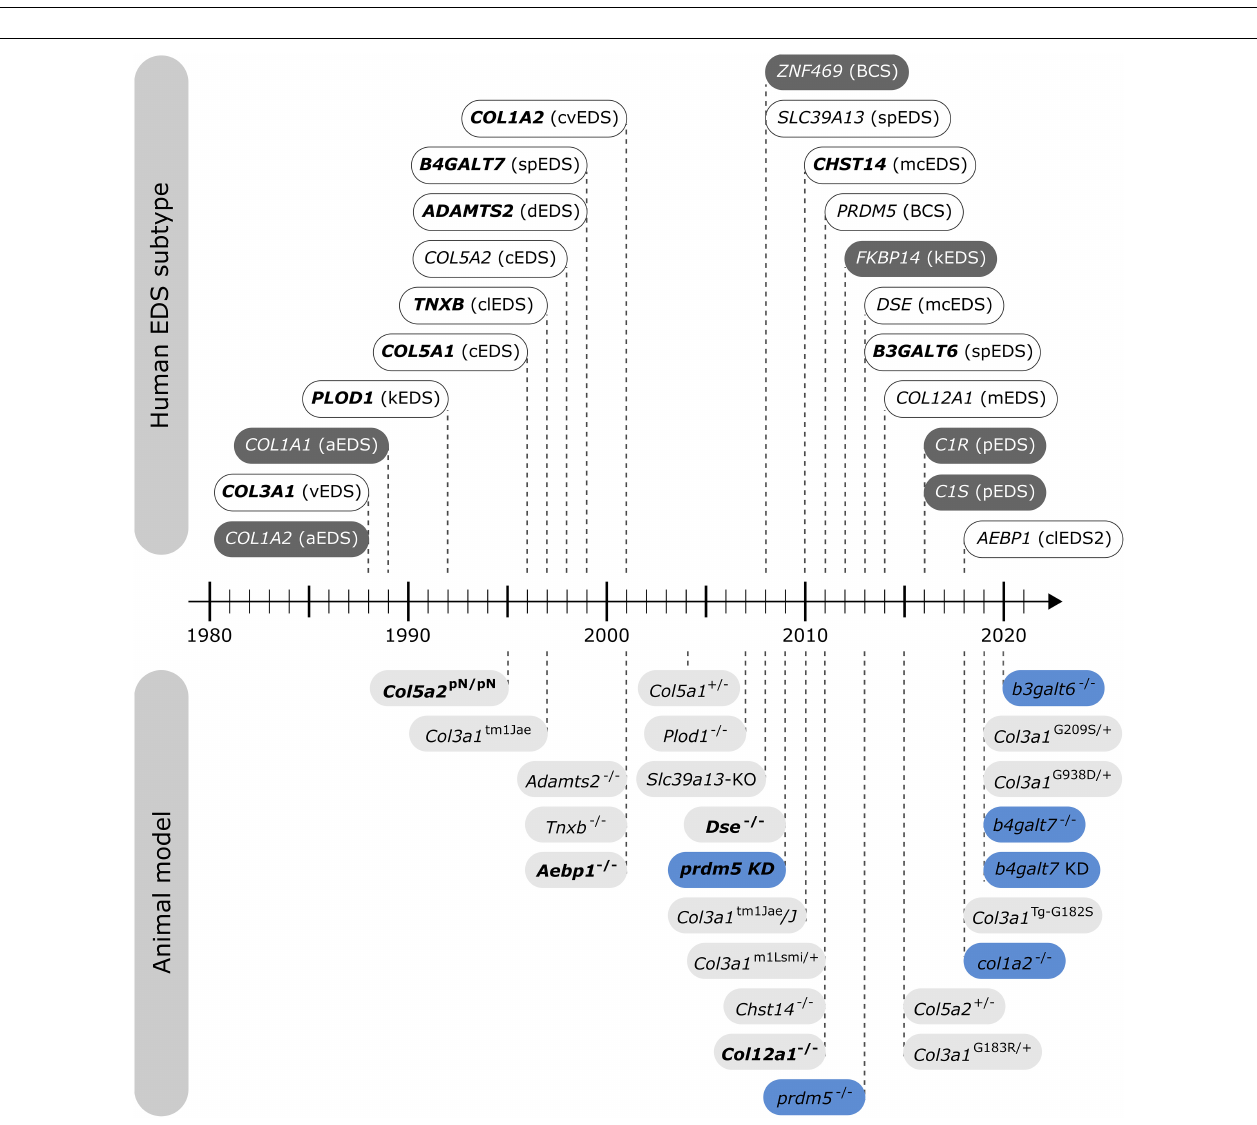
FIGURE 2 | Timeline illustrating the first identification of molecular defects in human EDS (above timeline) and the first description of engineered animal models targeting an EDS-associated gene (below timeline). Human genes associated with EDS without a corresponding animal model are indicated in dark gray. Note that for some human EDS subtypes, biochemical and/or ultrastructural findings preceded the identification of the molecular defect. Mouse models are depicted in light gray and zebrafish models in blue. Bold indicates what was first, either the identification of the human disease gene or the generation of the engineered animal